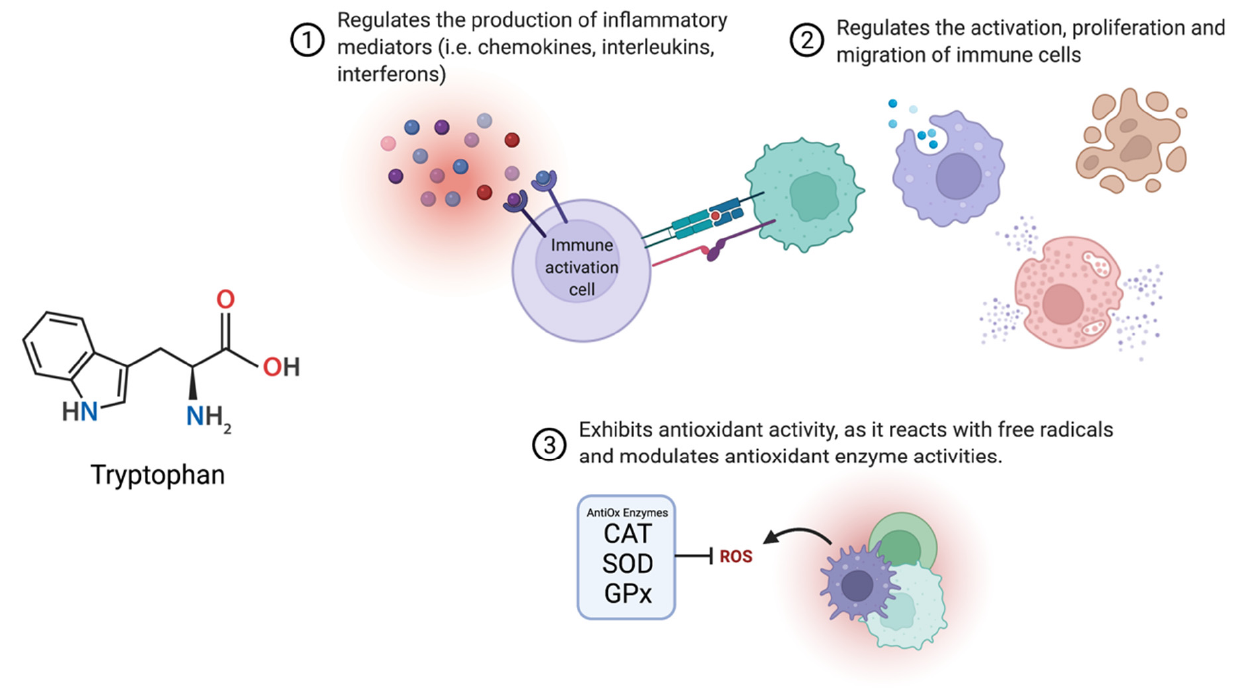
Figure 5. TRP functions as a regulator of inflammatory signaling molecules that control the immune response and the antioxidant response to cell stress and tissue damage. Figure created on bioren- der.com.